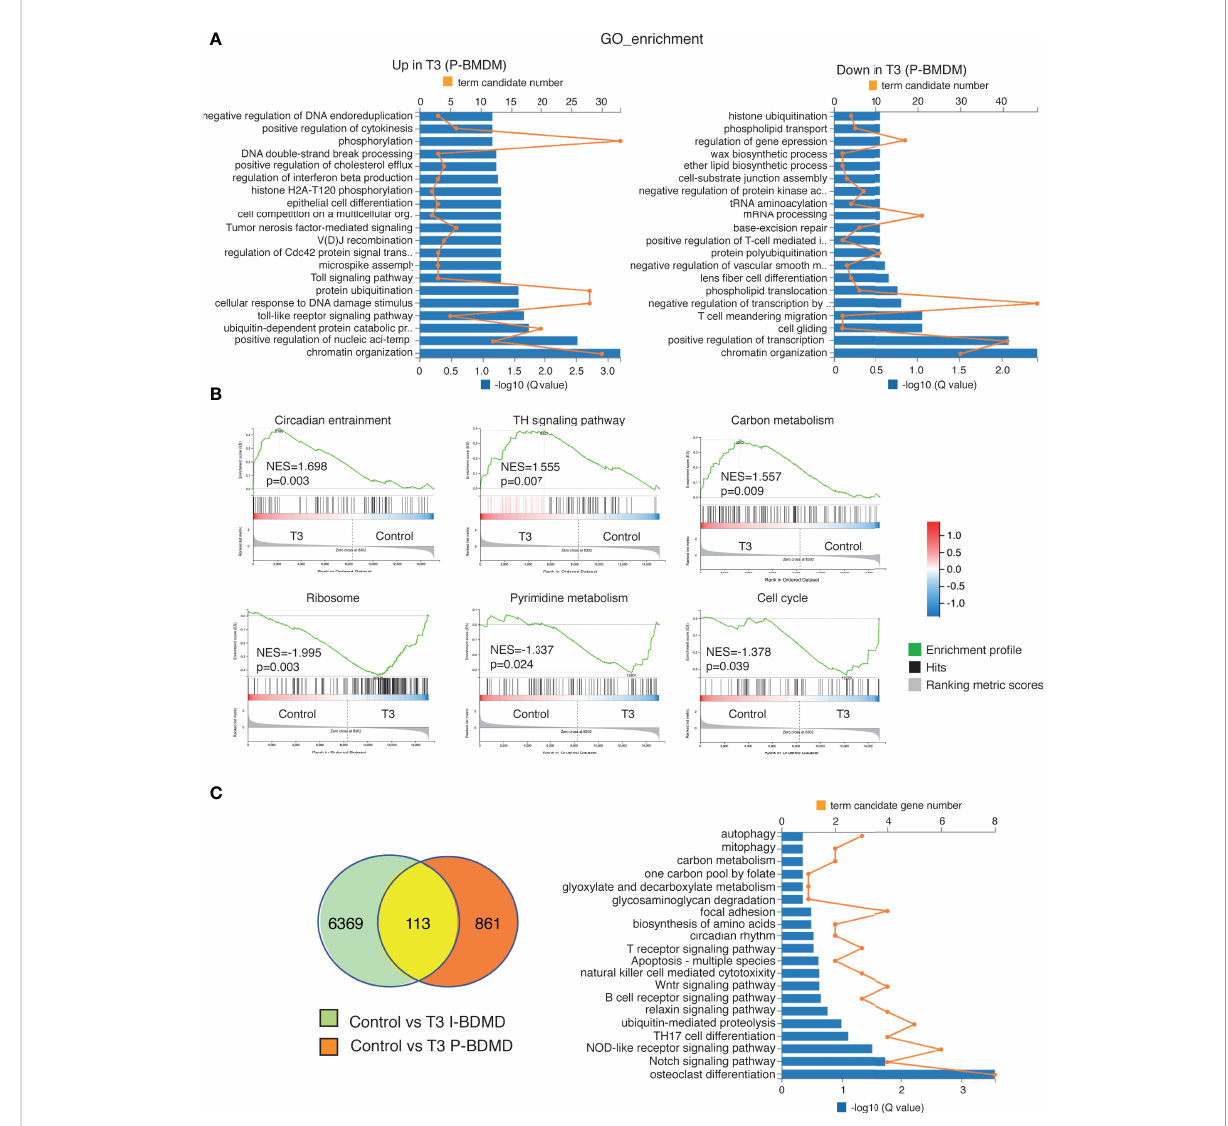
FIGURE 7 Transcriptional pro fi ling of T3-treated primary macrophages. (A) Gene ontology (GO) categories with signi fi cant enrichment (left panel) or reduction (right panel) in the transcripts of T3-treated primary cultures of macrophages (P-BMDM) with respect to the untreated cells. Both the term candidate transcript number (in orange) and the Q value (in blue bars) are represented. (B) Enrichment plots from Gene Set Enrichment analysis (GSEA) based in the KEEG pathway database showing the top over-represented hallmarks in up-regulated and down-regulated genes in T3-treated P-BMDM. The normalized enrichment scores (NES) as well as the nominal p values are shown. (C) Venn diagram of the intersection between transcripts regulated by T3 in both I-BDMD and P-BMDM (left) and GO categories of the overlapping transcripts regulated by T3 based in q values